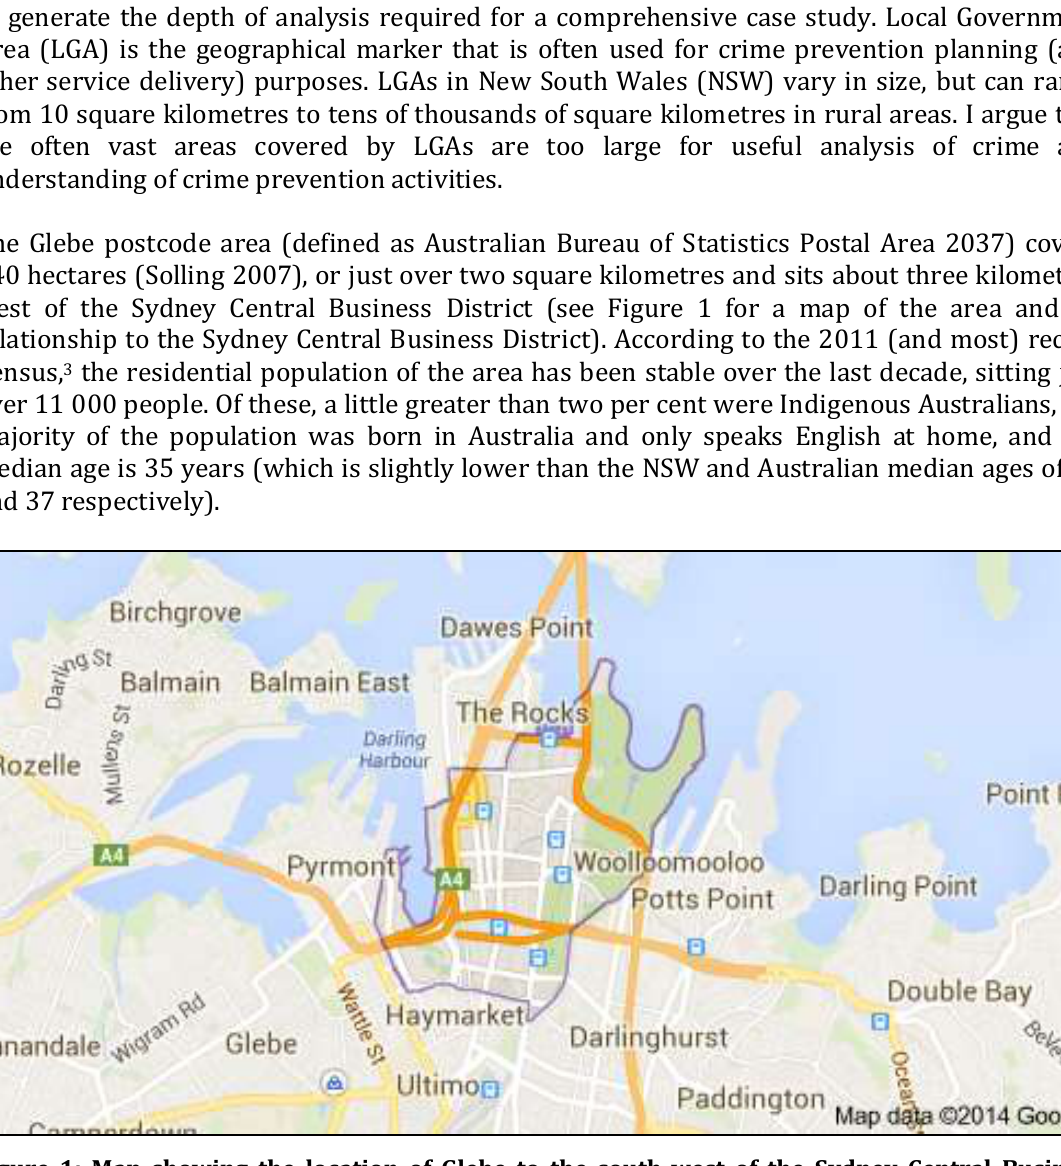
Figure 1: Map showing the location of Glebe to the south-west of the Sydney Central Business District (bordered area) Source: Google